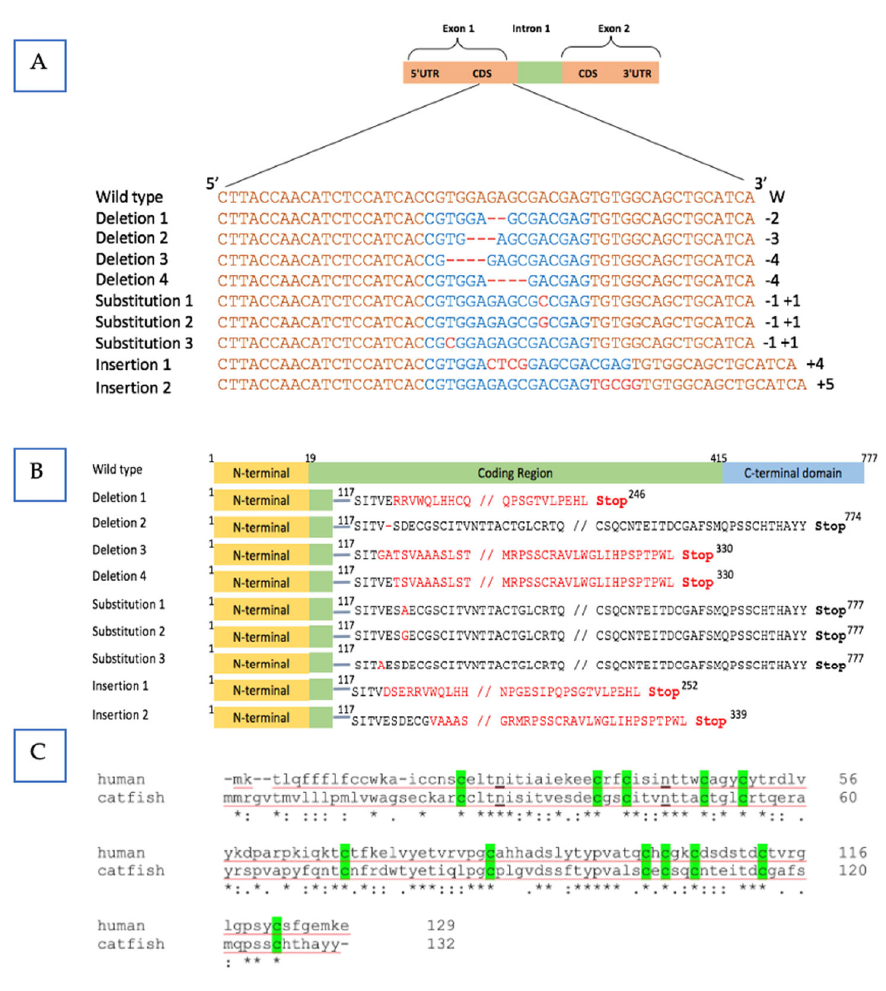
Figure 2. Sequence analysis of the mutated follicle ‐ stimulating hormone ( fsh ) gene in channel catfish ( Ictalurus punctatus ). ( A ) Sequence analysis of the nucleic acid in the mutated fsh gene. The channel catfish fsh nucleotide sequence of the wild ‐ type is displayed at the top. Orange highlighted se ‐ quences represent the target binding sites of the transcription activator ‐ like effector nucleases (TALENs). Blue colored sequences represent the predicted cleavage sites of the nucleases. The mu ‐ tation types (deletion/insertion/substitution) of nucleotides are shown by red dashes and letters. Numbers of nucleotides deleted ( ‐ ) or inserted (+) in the edited fsh gene are denoted on the right side of the sequences. ( B ) Sequence analysis of corresponding predicted amino acid in the fsh mu ‐ tants. Frameshift reading resulted in a premature stop codon (red colored). Single amino acid dele ‐ tions or substitutions were caused by changes in one nucleotide mutations or three nucleotide dele ‐ tions that are highlighted in red. ( C ) Bright ‐ green shaded areas are the Cys residues, and N ‐ linked glycosylation sites are underlined. The asterisk “*” indicated the same amino acid between normal human and wild ‐ type catfish. Because neither sequence from the TAL repeats region nor CMV promoter region could be PCR amplified in the plasmid integration assessment, it suggests that no plasmid DNA was present using PCR for all TALEN ‐ fsh ‐ defective fish. The results concluded that none of the tested samples harbored the foreign DNA (Figures 3 and S3).